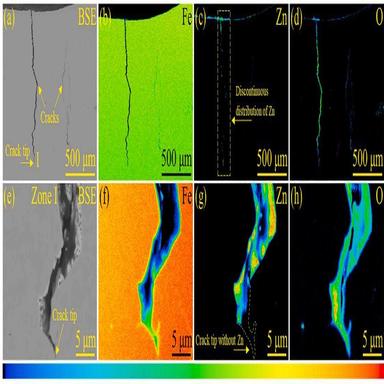
SEM images and EPMA results of the region adjacent to the LME crack in the cross-section of the spot weld: (a) backscattered electron (BSE) image of the region adjacent to the whole LME crack, (b)-(d) elemental distributing mapping of elements Fe, Zn and O, respectively, (e) BSE image of the region adjacent to the LME crack tip in region I indicated in (a), and (f)-(h) elemental distributing mapping of elements Fe, Zn and O, respectively.